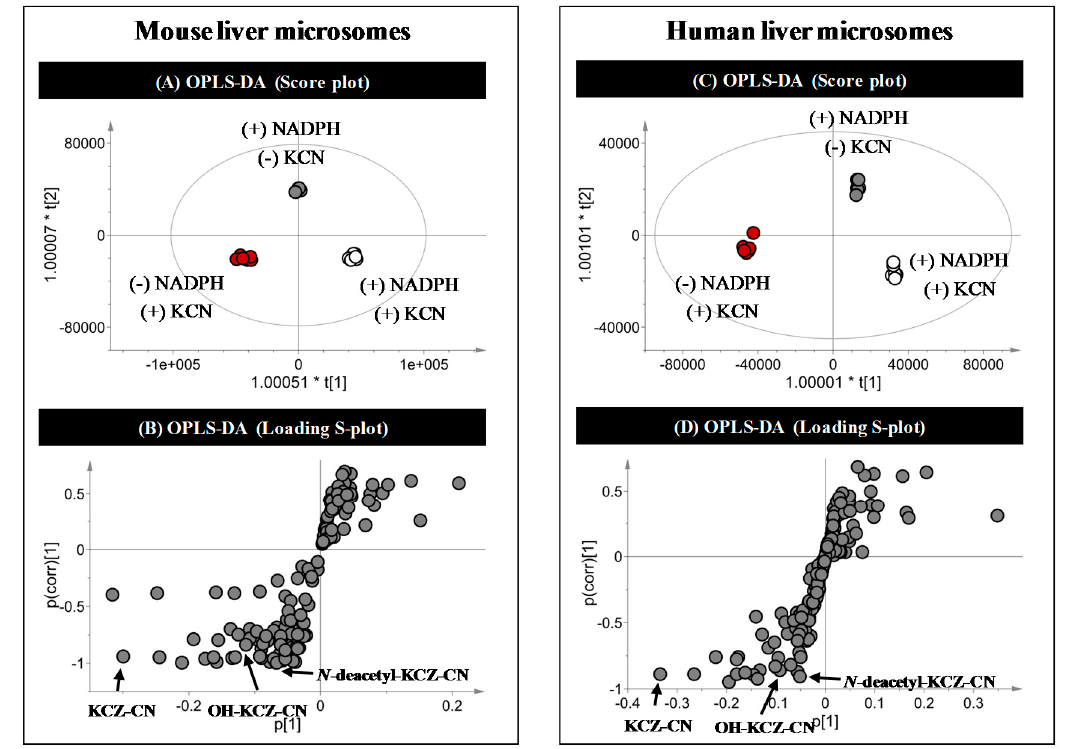
Figure 6. Multivariate data analysis for profiling of ketoconazole cyanide adducts. ( A ) Score plot and ( B ) loading S-plot generated by OPLS-DA from mouse liver microsomal incubations; ( C ) Score plot and ( D ) loading S-plot generated by OPLS-DA from human liver microsomal incubations.